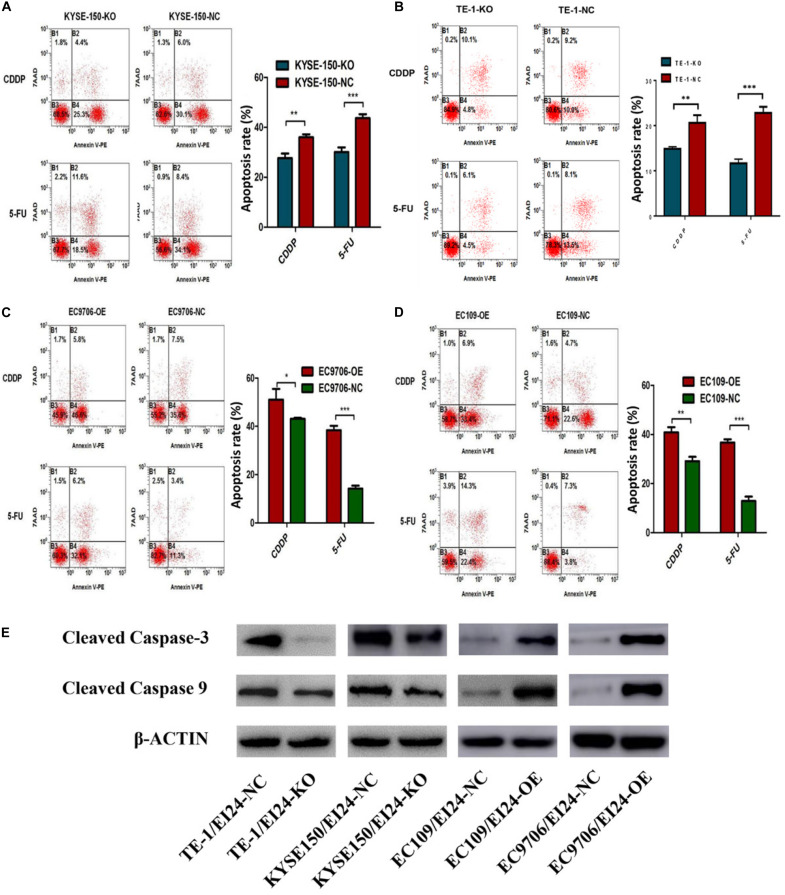
Effects of EI24 knockdown or overexpression on apoptosis in esophageal squamous cell carcinoma (ESCC) cells. (A–D) Flow cytometric analysis of the role of EI24 in 5-fluorouracil (5-FU) or cisplatin (CDDP)-induced apoptosis. (A,B) EI24 depletion significantly decreased the proportion of apoptotic cells in EI24-KO cells compared with controls. (C,D) Overexpression of EI24 significantly increased the proportion of apoptotic cells in EI24-OE cells compared with controls. (E) Western blot analysis of the expression of cleaved caspase-3 and cleaved caspase-9 in ESCC cells. Cleaved caspase-3 and cleaved caspase-9 expressions were decreased in EI24-KO cells compared with EI24-NC cells. EI24 overexpression reversed this effect on cleaved caspase-3 and cleaved caspase-9 expression. β-Actin was used as an internal control. *P < 0.05, **P < 0.01, ***P < 0.001.